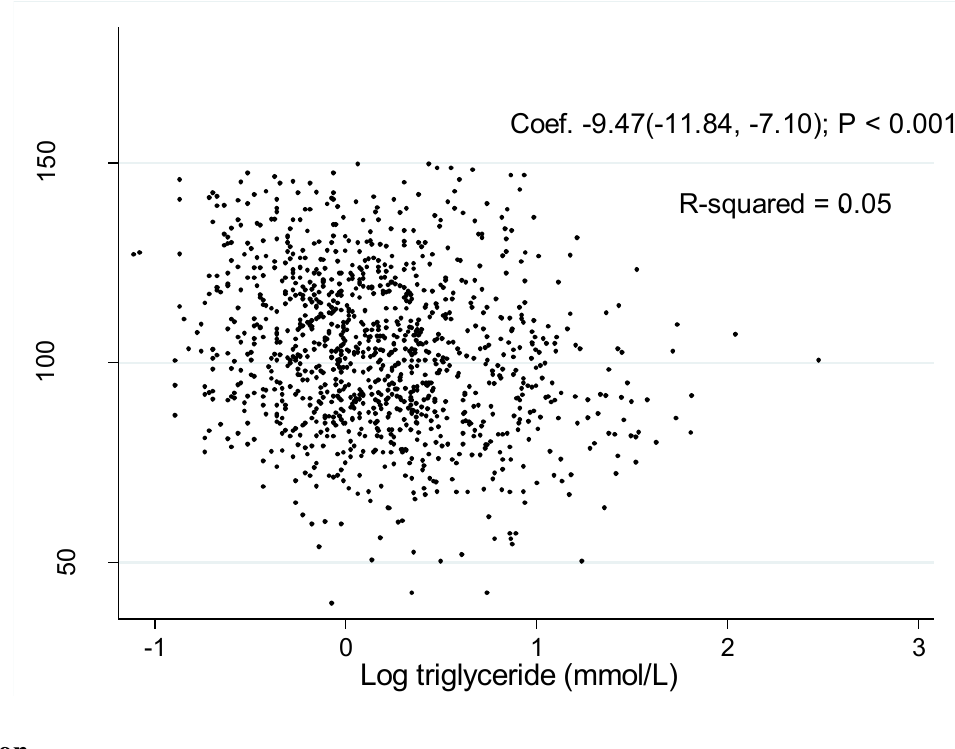
Figure 2. Association of estimated glomerular filtration rate with log triglyceride in